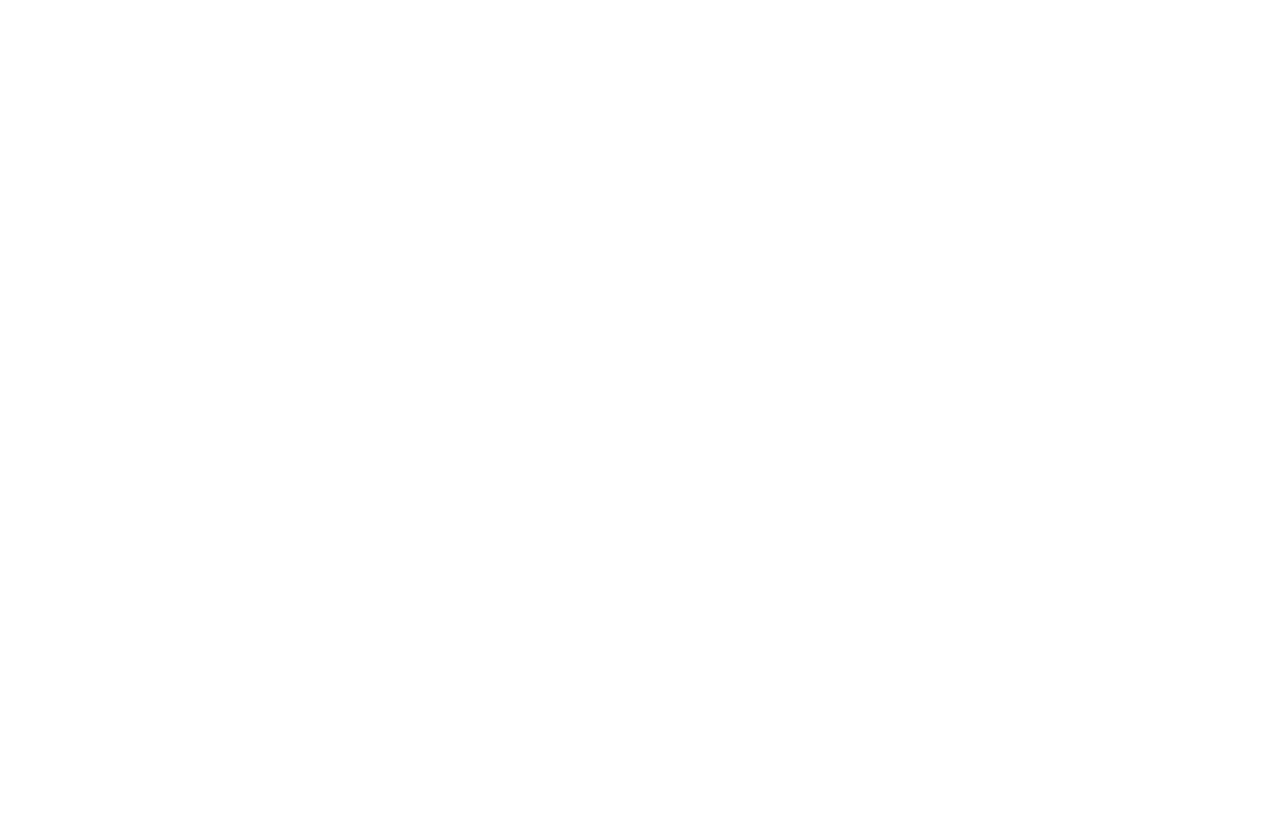
FIGUREA4 | Scatterplot of the identified 45 metabolites that were significantly changed between the wildtype and the crp mutant. Metabolites which differed ≥ 2-fold between the wildtype and the crp mutant were indicated by